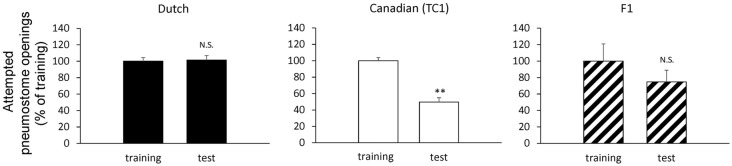
Comparison of the pneumostome opening attempts between the training session (training) and the memory test (test) in the Dutch snails (black, N = 60), the Canadian TC1 snails (white, N = 60) and the F1 cross snails (hatched, N = 28) in the operant conditioning of aerial respiratory behavior. The number of pneumostome opening attempts was counted over 0.5 h during the training session and the memory test 24 h later. The data are shown in percentages, indicating that the results of F1 cross snails resembled those of the Dutch snails. We calculated the statistical significant using the raw data. **P < 0.01; N.S., not-significant. The statistical analysis was performed usign a paired t-test.